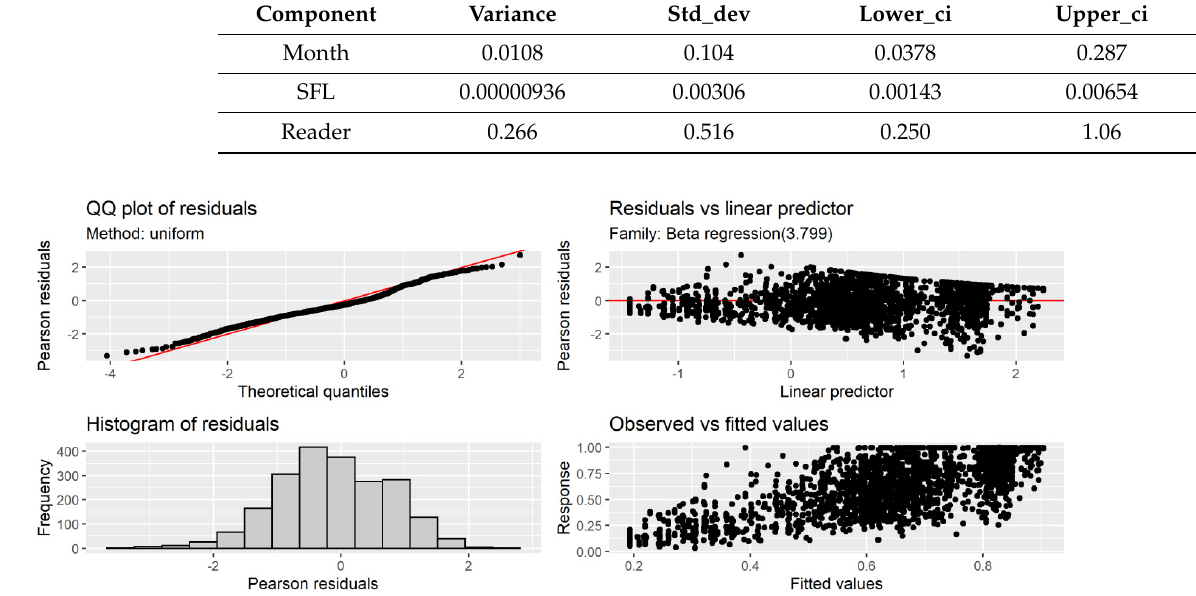
Figure 7 . Prediction interval for the month of capture effect from the GAM model. Figure 7. Prediction interval for the month of capture effect from the GAM model. Table 1. The variance and standard deviation for each smooth in the final GAM model. Component